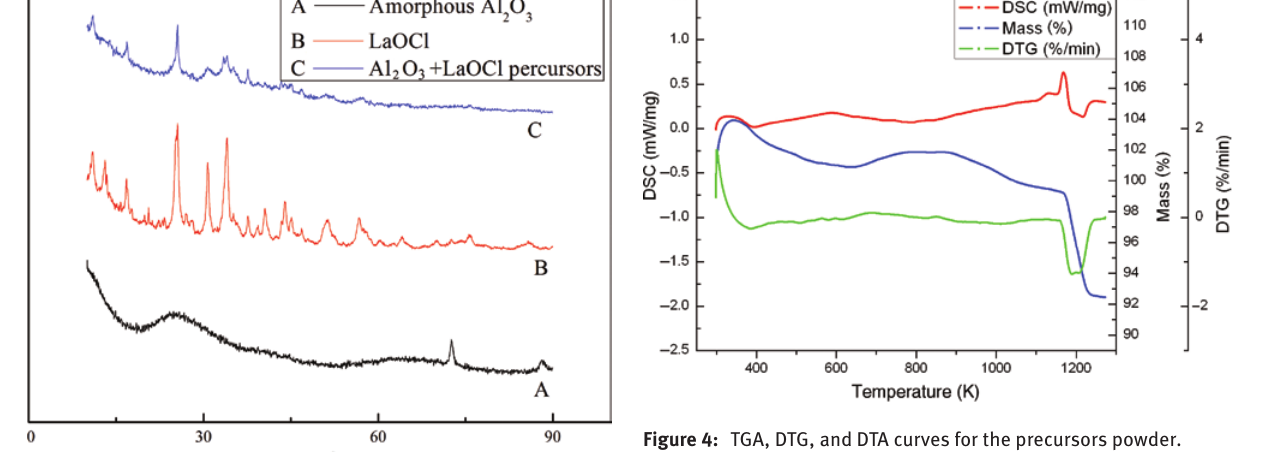
Figure 2: X-ray diffraction patterns of amorphous Al talline LaOCl,Al